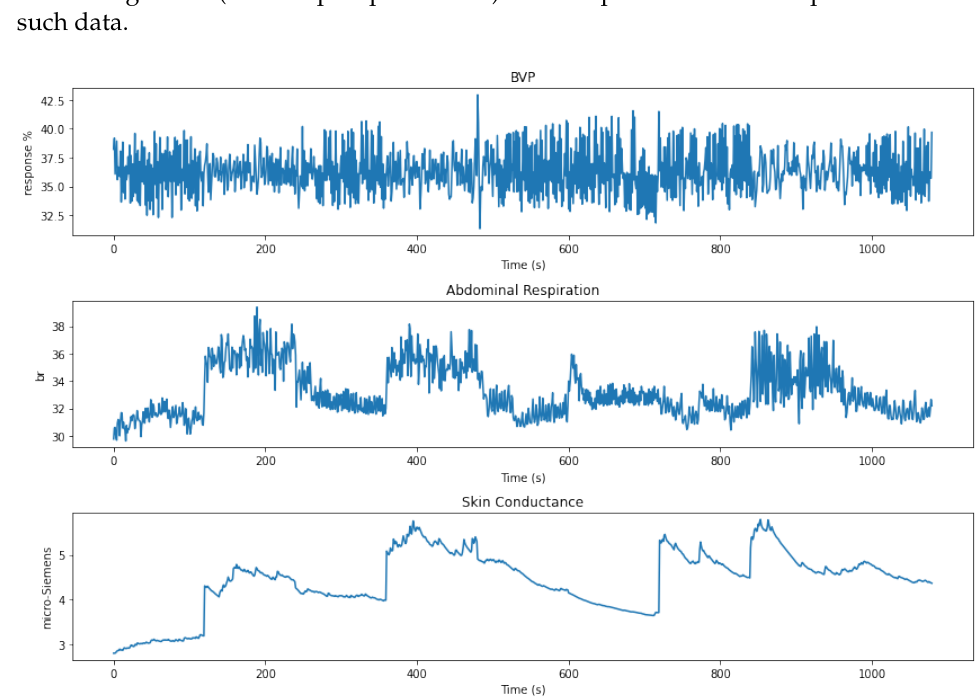
Figure 1. Raw signal of the three physiological variables of subject 14 (woman, age 21), during the ProComp5